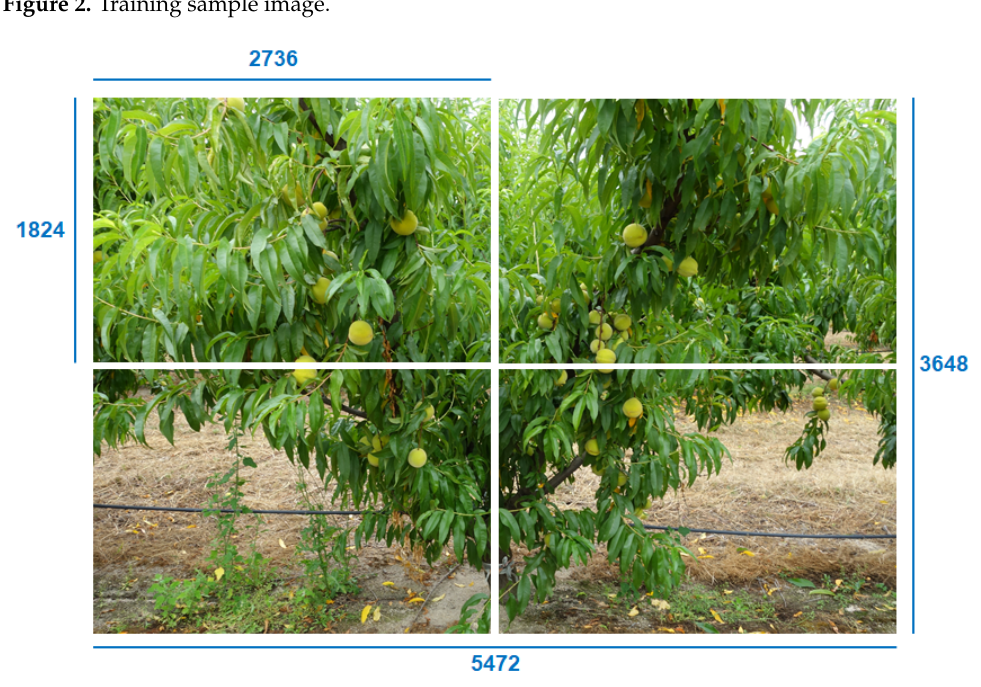
Figure 3. Process of cropping the original image into four